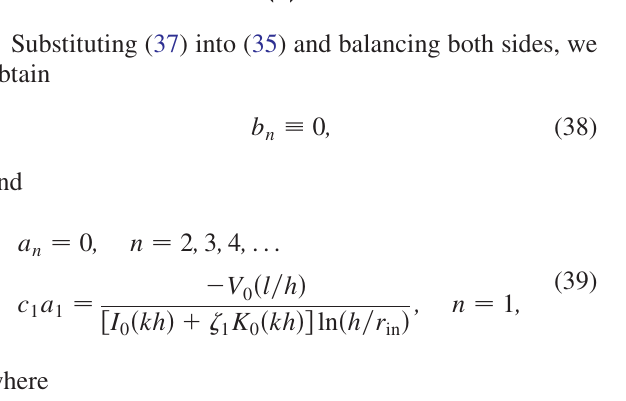
r=6.04 mm solid line--analytical formula dashed line--CST simulation